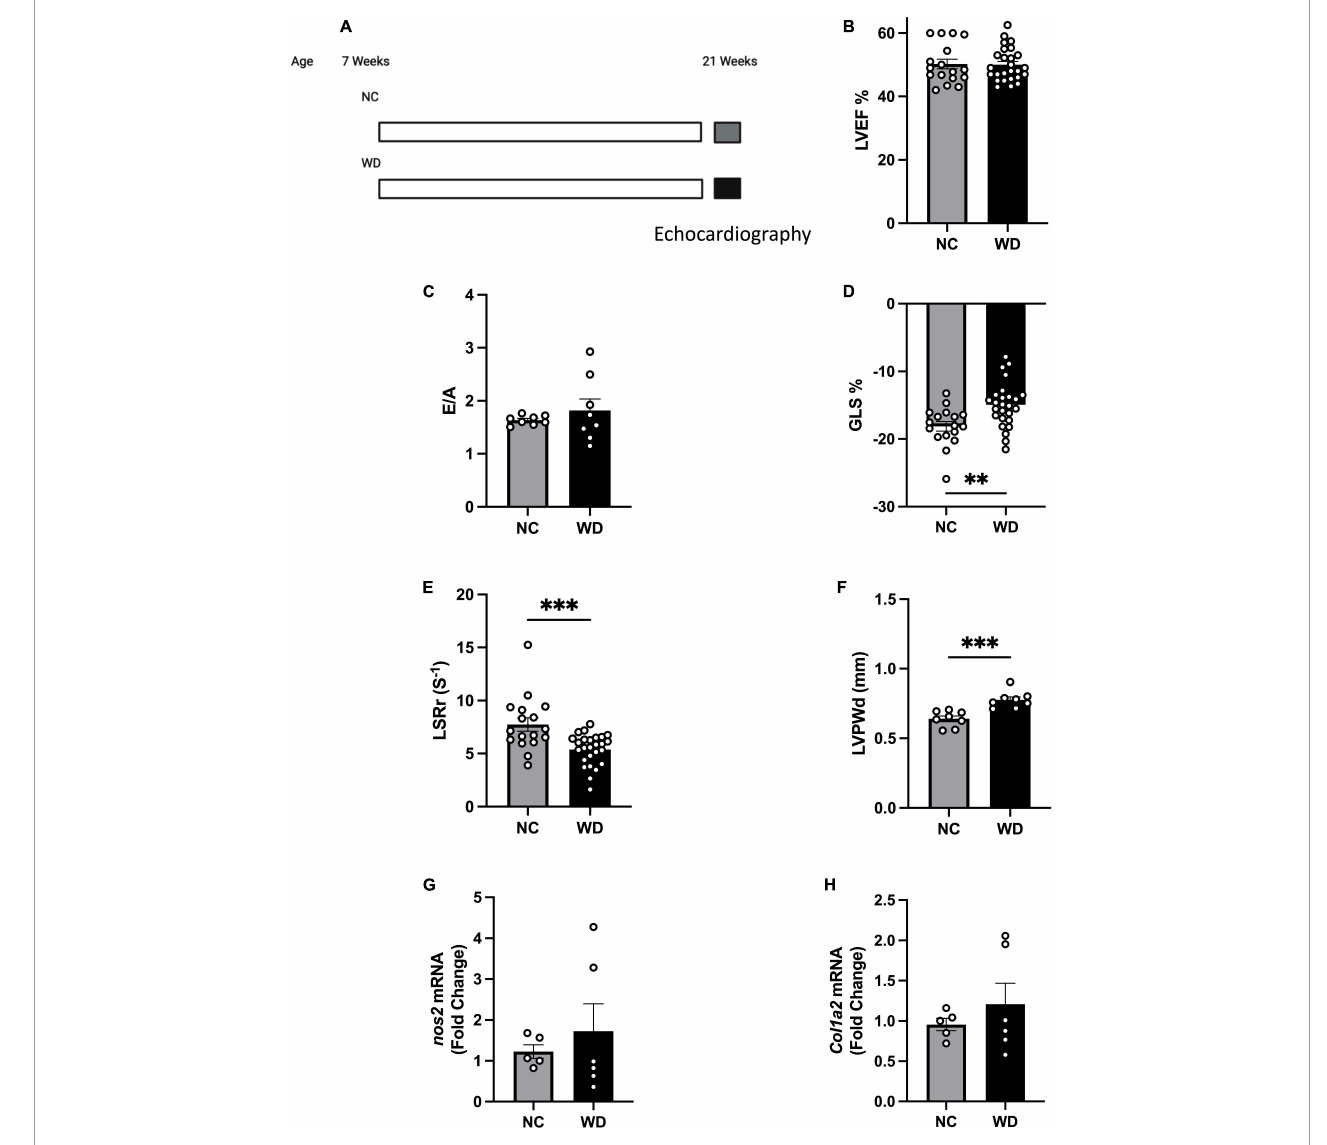
FIGURE1 Mice fed western diet (WD) developed early systolic and diastolic dysfunction and cardiac hypertrophy. (A) Experimental paradigm. Normal chow group was fed NC (Teklad LM-485), while the western diet group was fed WD (TD88137, Teklad Diets; 42% kcal from fat, 34% sucrose by weight, and 0.2% cholesterol total; Envigo) for 14 weeks, starting at 7 weeks of age. Echocardiography measurements were performed at 21 weeks of age, (B) echocardiography measurement of left ventricle ejection fraction (LVEF), (C) ratio between early to atrial diastolic trans mitral flow velocity (E/A), (D) global longitudinal strain (%GLS), (E) longitudinal strain rate reverse (LSRr) (s - 1 ), (F) left ventricle posterior wall diameter during diastole (mm), (G,H) mRNA levels of nos2 and col1a2 in hearts of mice from different experimental groups, respectively. Statistical analysis was done using unpaired student’s t -test. Data are mean ± S.E.M. ( ∗ p < 0.05, ∗∗ p < 0.005, and ∗∗∗ p < 0.0005).